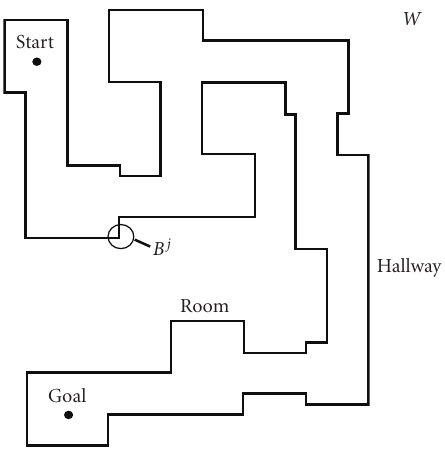
Figure 1: Example of virtual world, W , in 2D perspective with start and goal